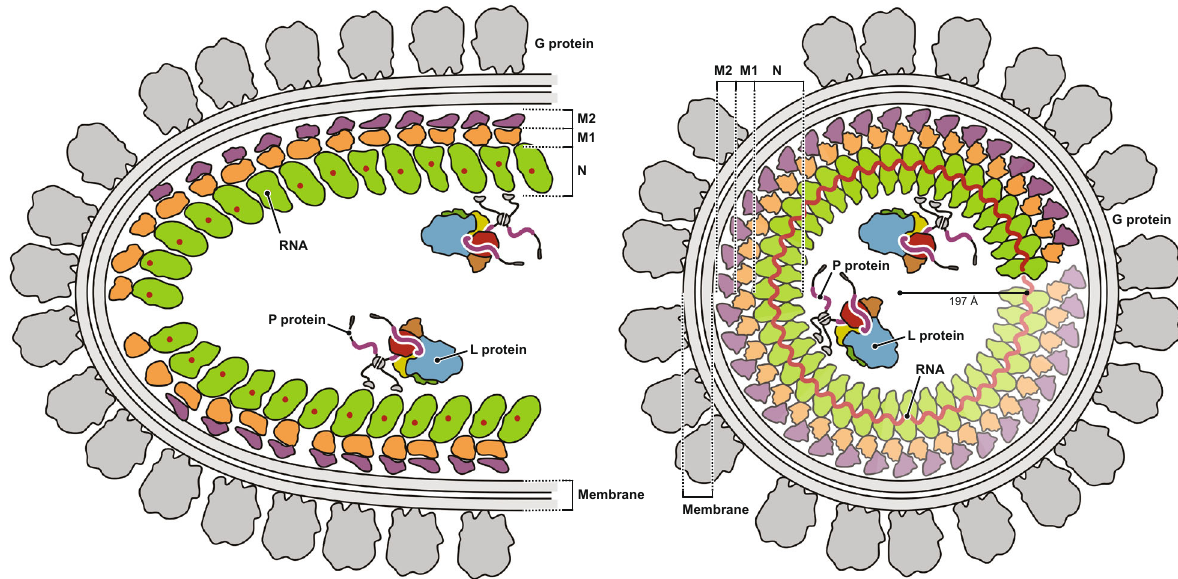
Fig.6|ModelofVSV. SchematicdiagramofVSV.AlongitudinalsectionoftheVSVtipisshownontheleft,acrosssectionofthehelicaltrunkontheright.Allviralproteins are drawn to approximate